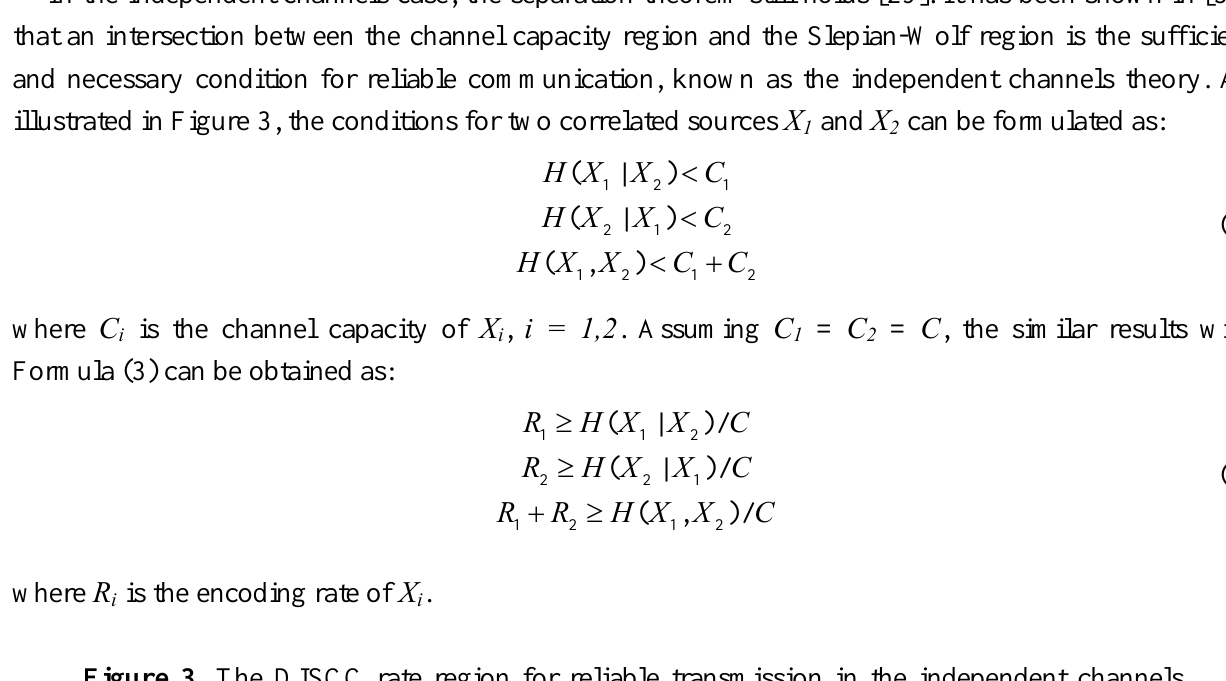
Figure 3. The DJSCC rate region for reliable transmission in the independent channels case: the intersection between the capacity region and the Slepian-Wolf rate